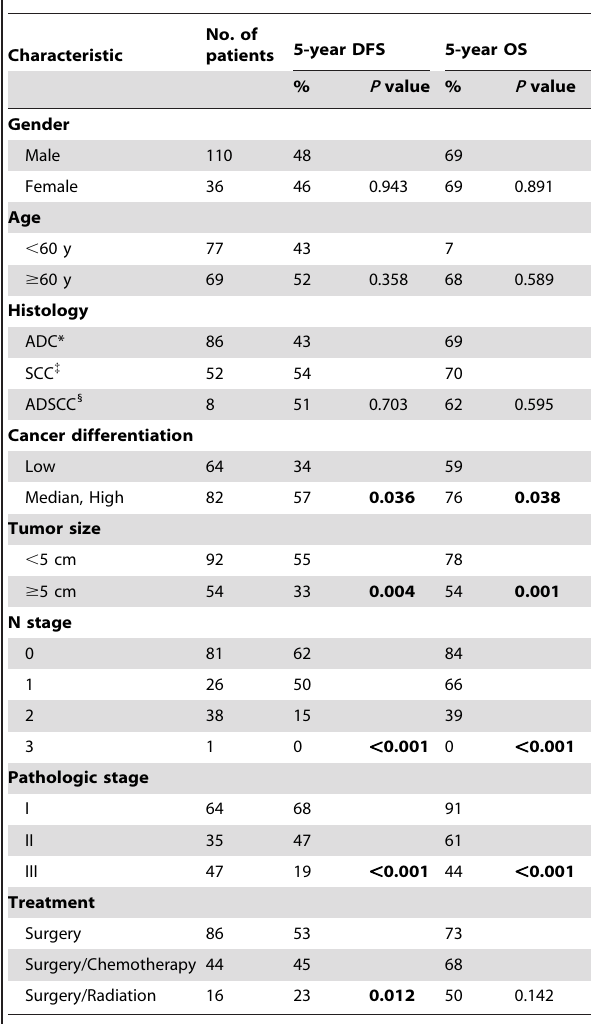
Table 1. Clinicopathologic variables as prognostic predictors for disease-free survival (DFS) and overall survival (OS) in 146 NSCLC patients (Univariate analyses; Log-rank